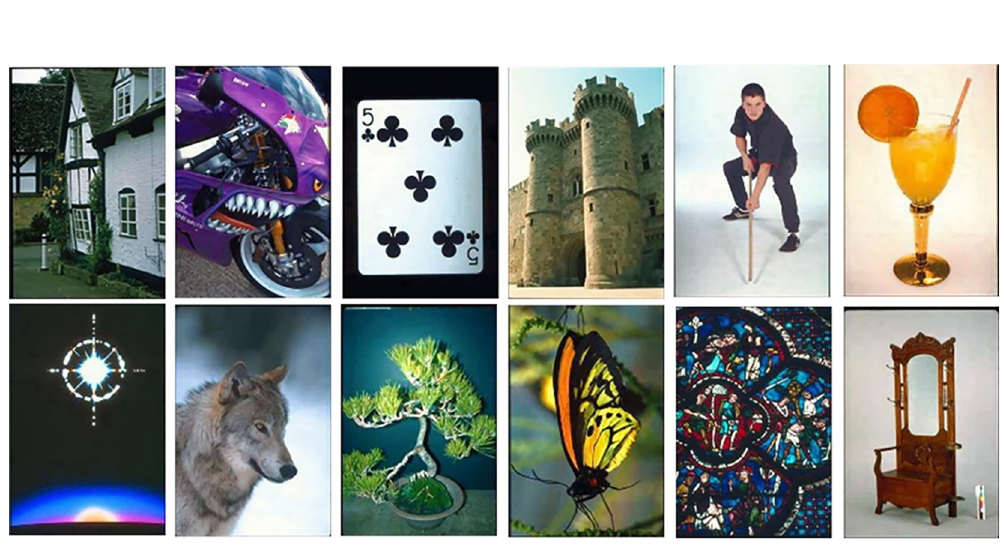
Fig 12. Sample images of the Wang 10k dataset (reprinted from [3] under a CC BY license, with permission from J. Z. WANG, original copyright [2003]).